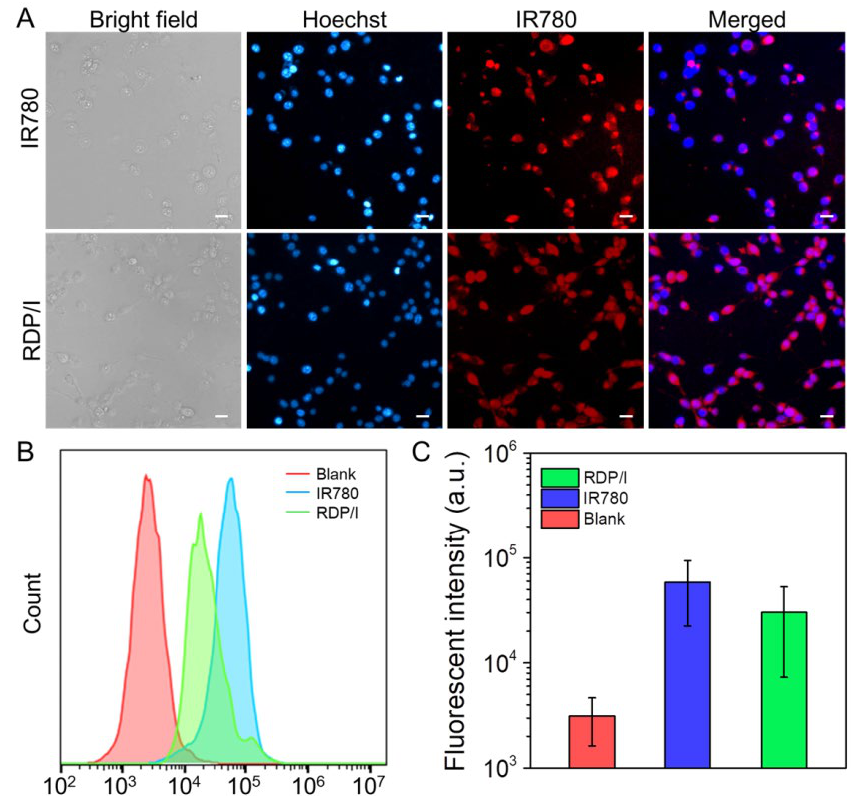
Figure 5. ( A ) CLSM images of CT26 cells after being treated with samples for 4 h; scale bar: 20 μm; ( B , C ) quantitative analysis of intracellular fluorescence intensity in CT26 cells after being treated with samples for 4 h.